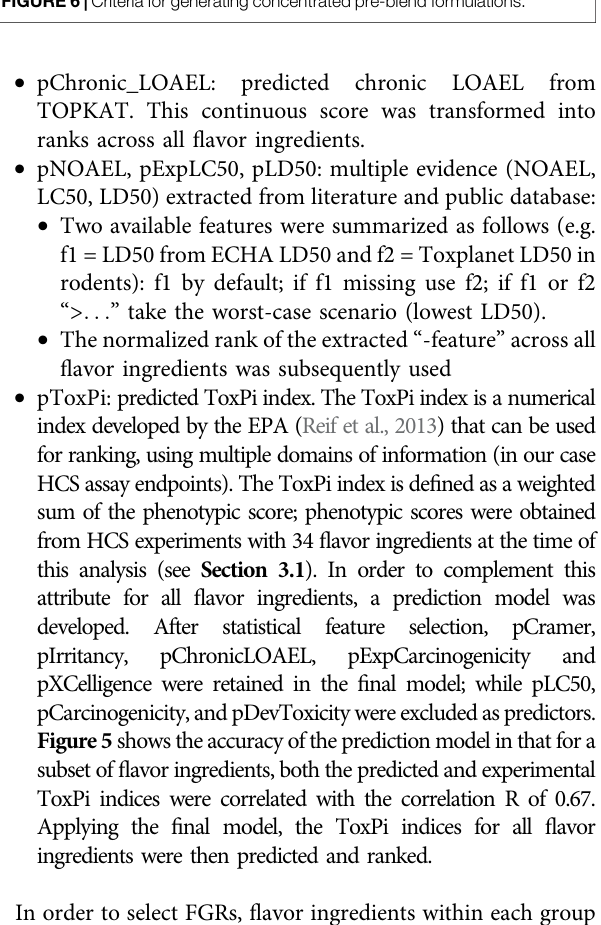
FIGURE 6 | Criteria for generating concentrated pre-blend